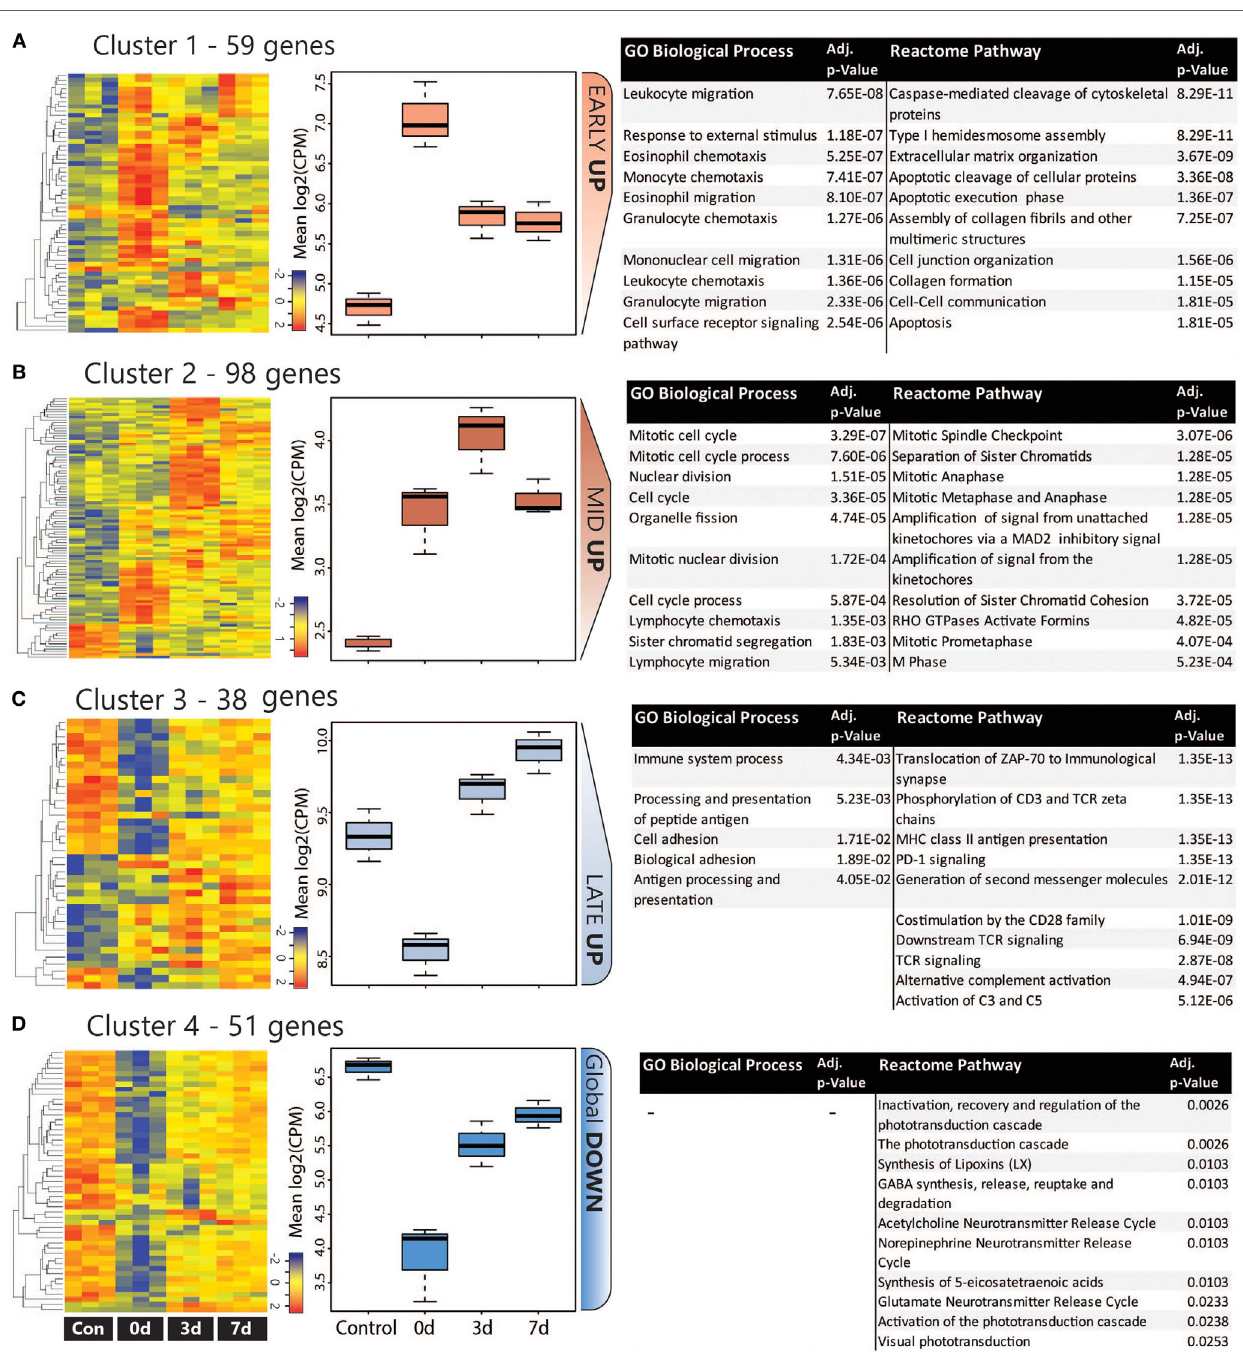
FigUre 4 | Analysis of co-regulated DEGs within the CD45 population following photo-oxidative damage. (a–D) K -means clustering was performed on the log2 cpm of 246 DEGs that were derived from the combined top 100 DEGs in each timepoint. Four major clusters were identified, as illustrated in the heat maps and box and whiskers plots, and variously termed (a) Early Up, (B) Mid Up, (c) Late Up, and (D) Global Down, based on their temporal expression pattern. The DEGs in each cluster were assessed for enriched terms and pathways using GO:BP and Reactome, respectively; the top entries for each are displayed, which were ranked according to the adjusted P value. Abbreviations: BP, biological process; DEG, differentially expressed gene; GO, gene